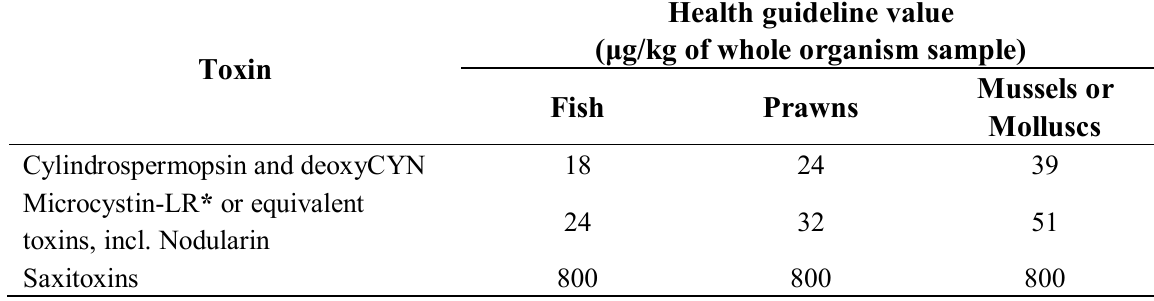
Table 6. Health guideline values for cyanobacterial toxins in seafood (based on consumption by 2–16 year age